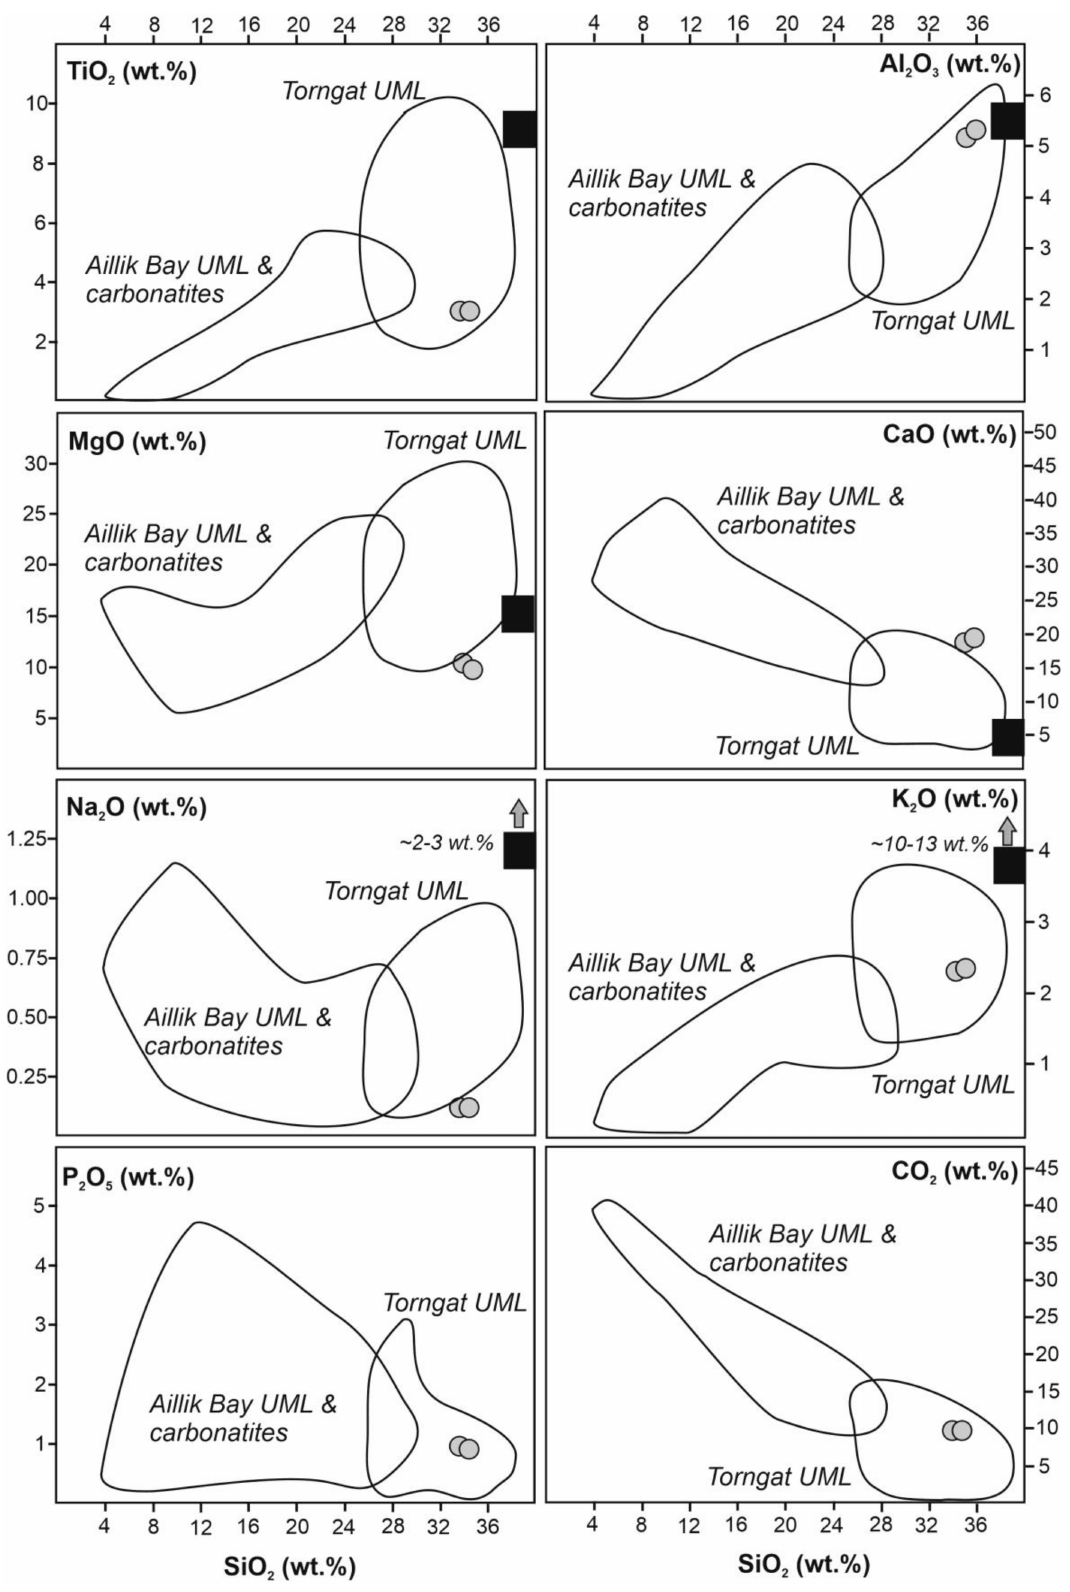
Figure 9. Major element oxide vs. SiO 2 (wt.%) of the Vinoren aillikite (gray circles). Also shown are the compositional fields of the diamond-bearing Torngat aillikite [35] and the diamond-free Aillik Bay aillikite [39] in Labrador which are of similar ages as the Vinoren rock. The black box shows the experimental melt compositions produced from MARID-type material